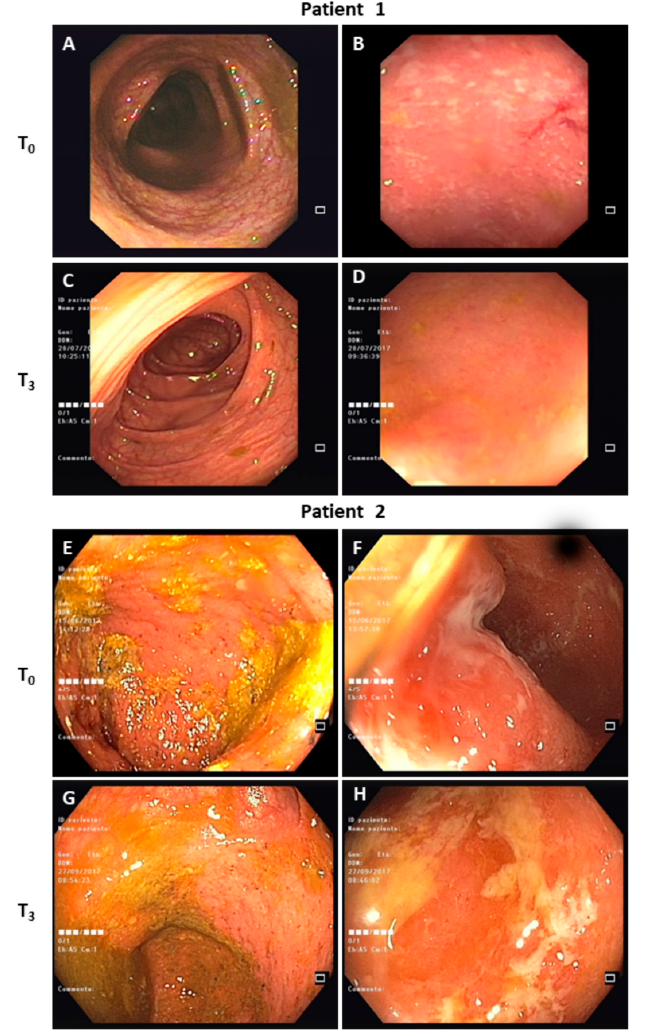
Figure 1. Colonoscopy images of Patients 1 and 2 at the time of FMT (T 0 ) and after 12 weeks (T 3 ) . Patient 1. Endoscopic appearance at T 0 : ascending colon, Mayo score 0 ( A ), and rectum, Mayo score 2 ( B ). Endoscopic appearance at T 3 : ascending colon, Mayo score 0 ( C ), and rectum, Mayo score 1 ( D ). Patient 2. Endoscopic appearance at T 0 : ascending colon, Mayo score 1 ( E ), and rectum, Mayo score 2 ( F ). Endoscopic appearance at T 3 : ascending colon, Mayo score 1 ( G ), and rectum, Mayo score 2 ( H ). Endoscopic Mayo score. Score 0: normal mucosa, pale pink, smooth, and glistening, with evident submucosal blood vessels; score 1: erythema, decreased vascular pattern, mild friability; score 2: marked erythema, absent vascular pattern, friability, erosions (fibrinous exudate appearing as whitish material); score 3: spontaneous bleeding and